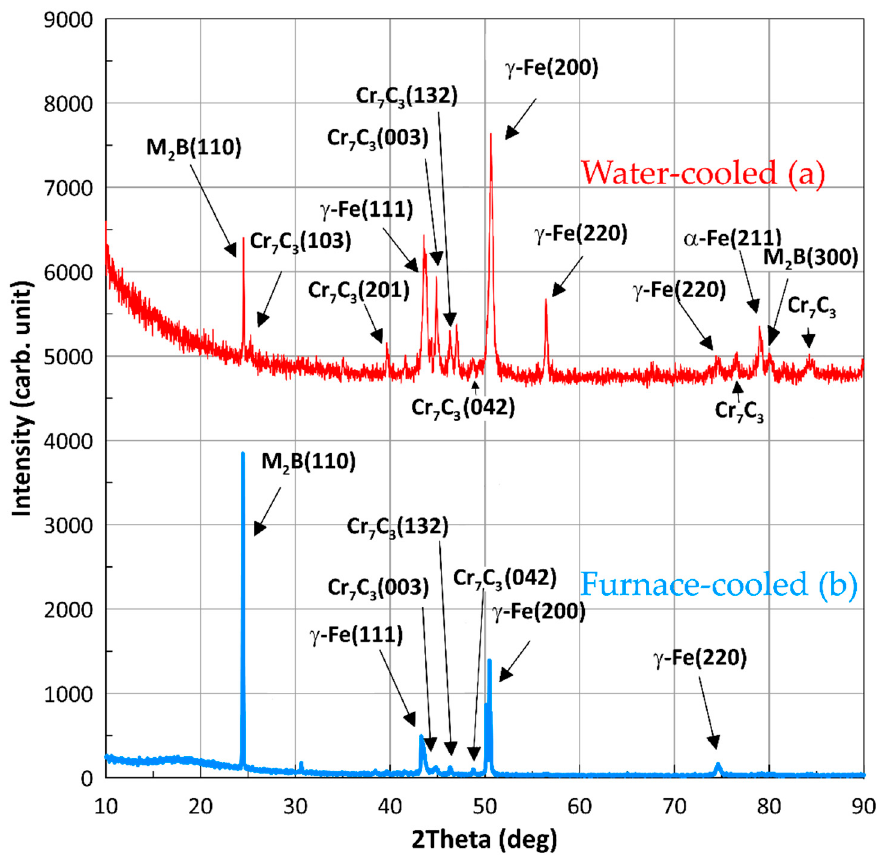
Figure 3. X-ray diffraction patterns for the Fe-C-Mn-B-Cr-Ni-Si alloy obtained under water ( a ) and furnace cooling ( b ).